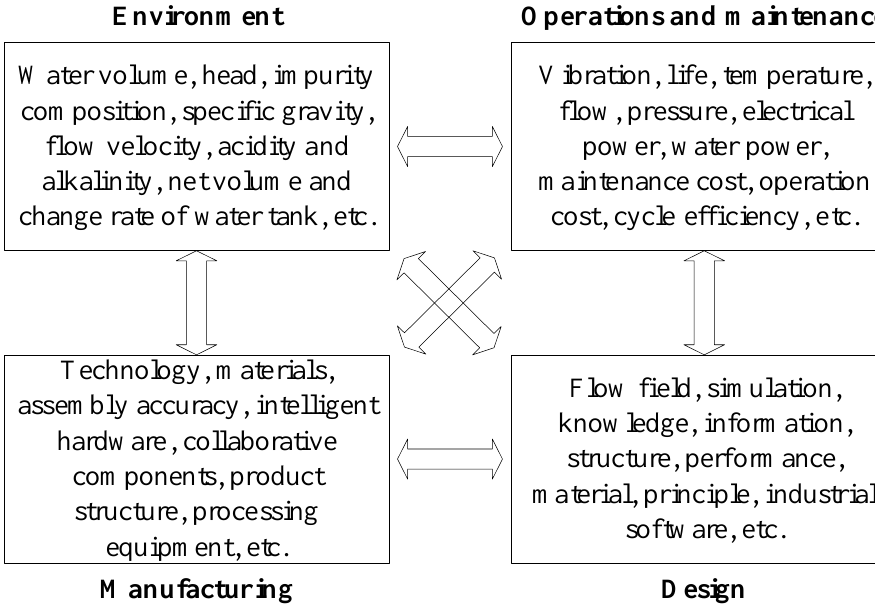
Figure 12. Influence parameters of self-balancing multistage pump development. Design parameters: hydraulic model selection (water wheel, guide vane), design efficiency, vibration calculation, strength calculation, purchased parts brand and specification, etc.